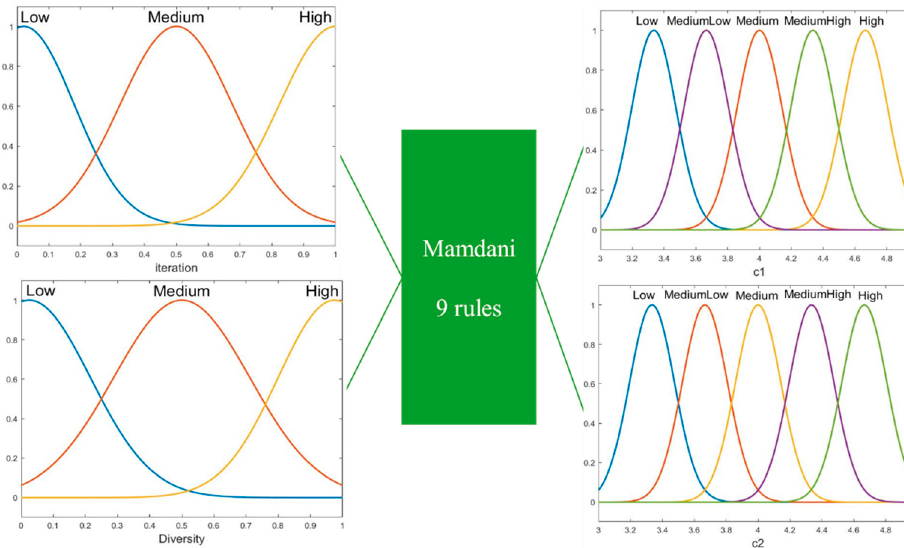
Figure 8. Fuzzy system proposed for the dynamic parameter adaptation designed with Gaussian MFs.